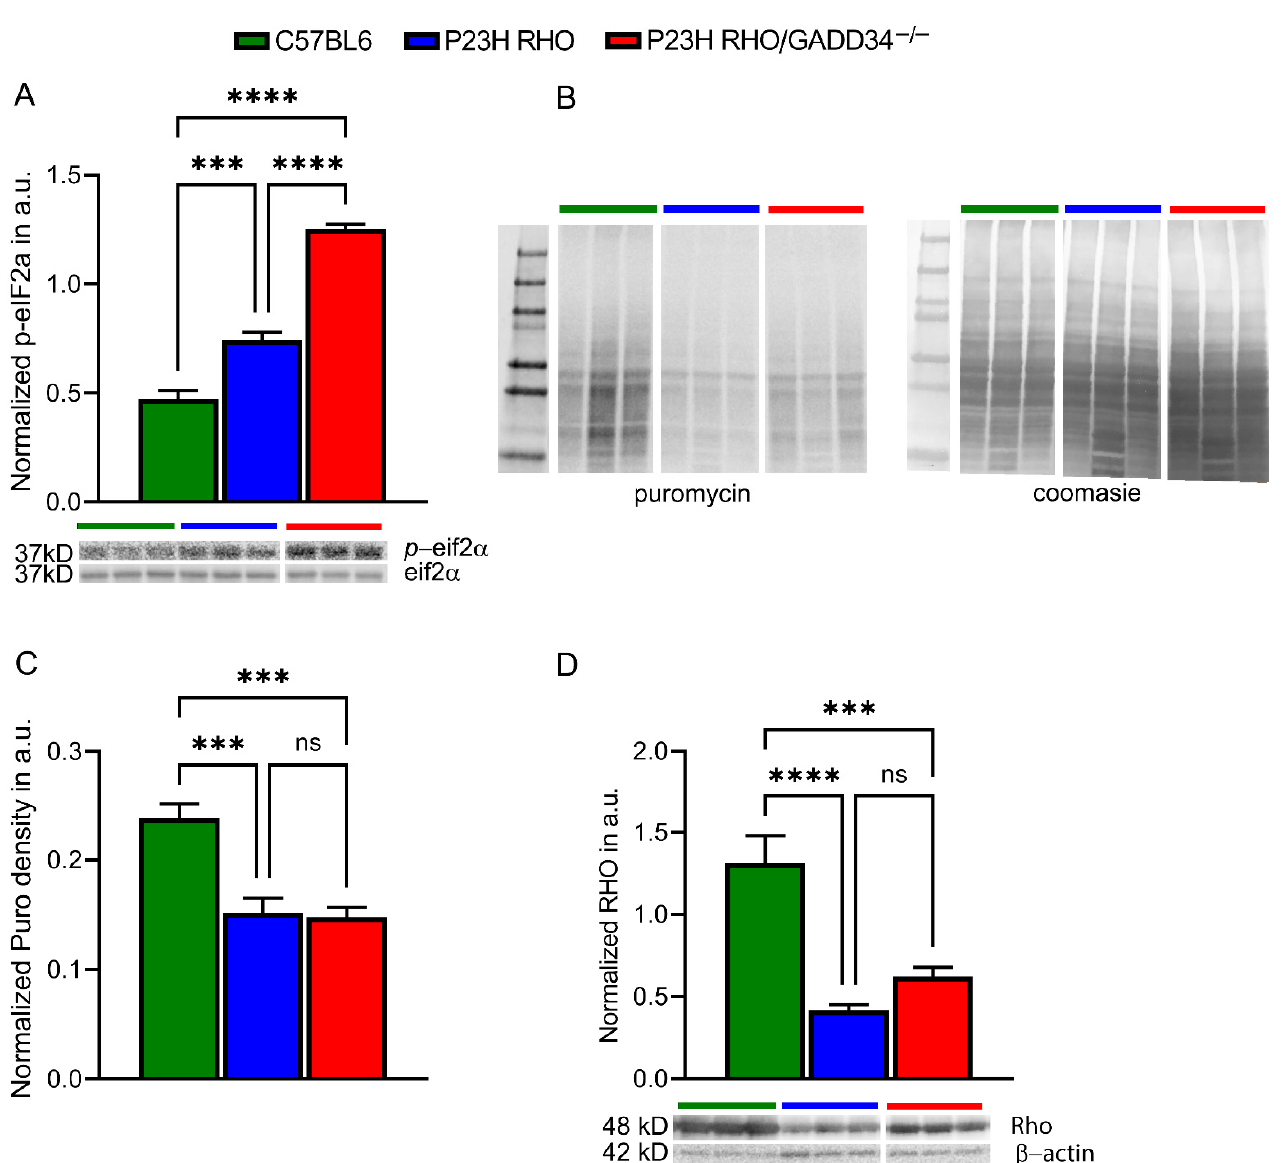
Figure 2. GADD34 deficiency results in an increase in p-eIF2 α levels and no further suppression of the translational rate in P23H RHO retinas. ( A ) Both the P23H RHO and P23H RHO GADD34 − / − retinas demonstrated an increase in p-eIF2a ( n = 4). Ablation of GADD34 in the P23H RHO retinas resulted in about a twofold elevation compared to the P23H RHO and C57BL5 control groups, respectively. ( B ) Using the SUnSET method with puromycin incorporated into nascent proteins in the retinas, newly synthesized proteins ( n = 4) were measured. Images of the Western blot stained with anti-Puro antibody and Coomassie were used to normalize the density of the incorporated puromycin. Puromycin immunoblotting was normalized to Coomassie-stained proteins. ( C ) A graph comparing the levels of translation in the C57BL6, P23H RHO, and P23H RHO GADD34 − / − retinas is shown. It was found that P23H RHO retinas manifest translational attenuation at P30 as compared to C57BL6 retinas. GADD34 ablation does not result in further translational repression in P23H RHO mice, although the p-eIF2 α is dramatically elevated. ( D ) Measurement of RHO protein in the wild-type and degenerating retinas revealed a significant decline in RHO levels in both the P23H RHO and P23H RHO GADD34 − / − mice ( n = 4). Relative density measurements correspond to the intensities of the immunoblotting bands or lanes normalized to the β -actin control. Data are shown as the mean ± SEM. a.u.: arbitrary units, *** p < 0.001, *** * p < 0.0001 and “ns”—not significant.